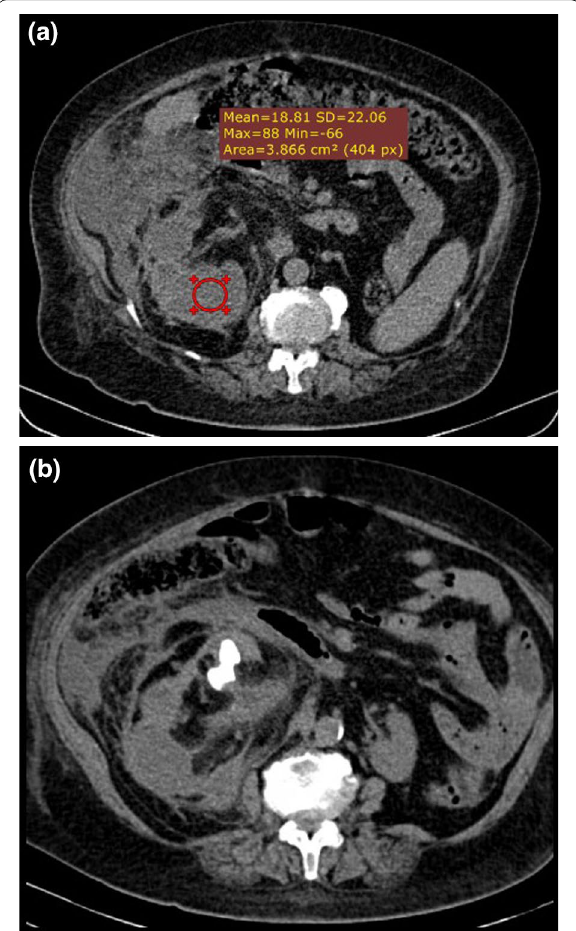
Fig. 5 a Axial CT scan showing swollen right kidney showing markedly dilated right pelvicalyceal system with marked smudging of perinephric fat planes. Mean HU within the dilated pelvicalyceal system 18.8 indicating the diagnosis of pyonephrosis. b Axial = CT scan of the same patient showing right large renal stones and marked smudging of the perinephric fat